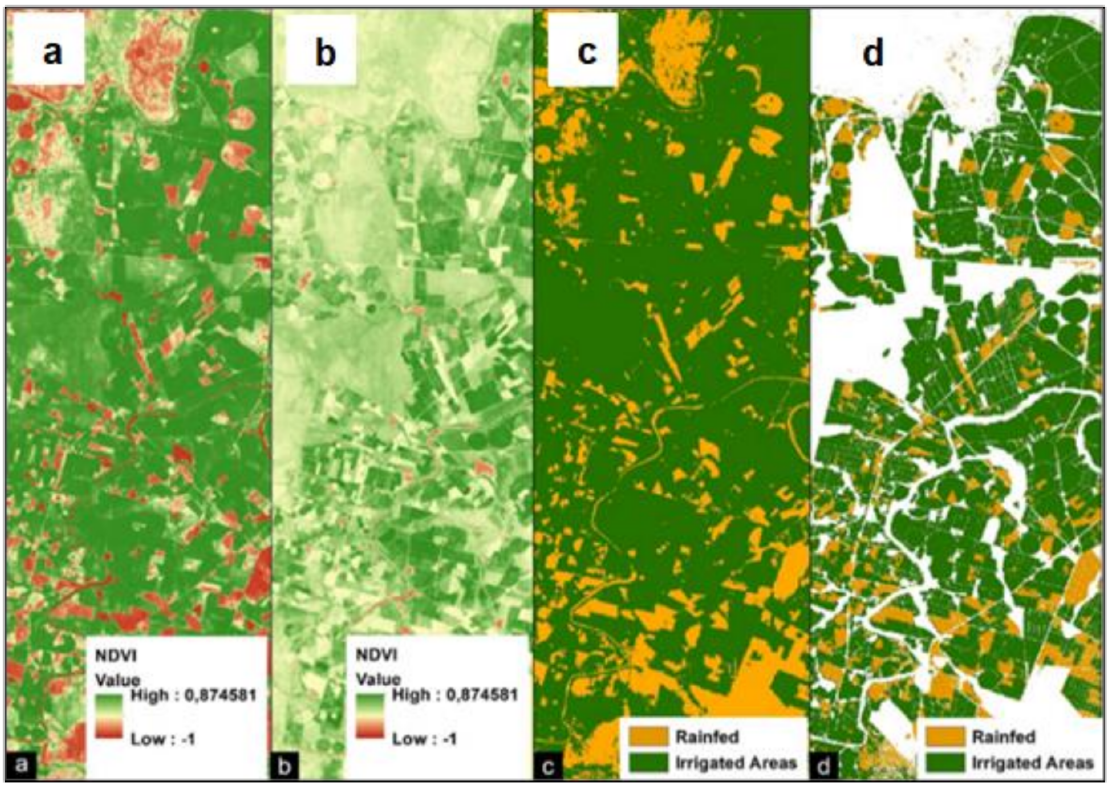
Figure 4. ( a ) Histogram equalisation of the NDVI average of July 2019; ( b ) sigmoid stretch of the NDVI average of July 2019; ( c ) The reclassified NDVI of July 2019 using a threshold; and ( d ) the classified cultivated land.